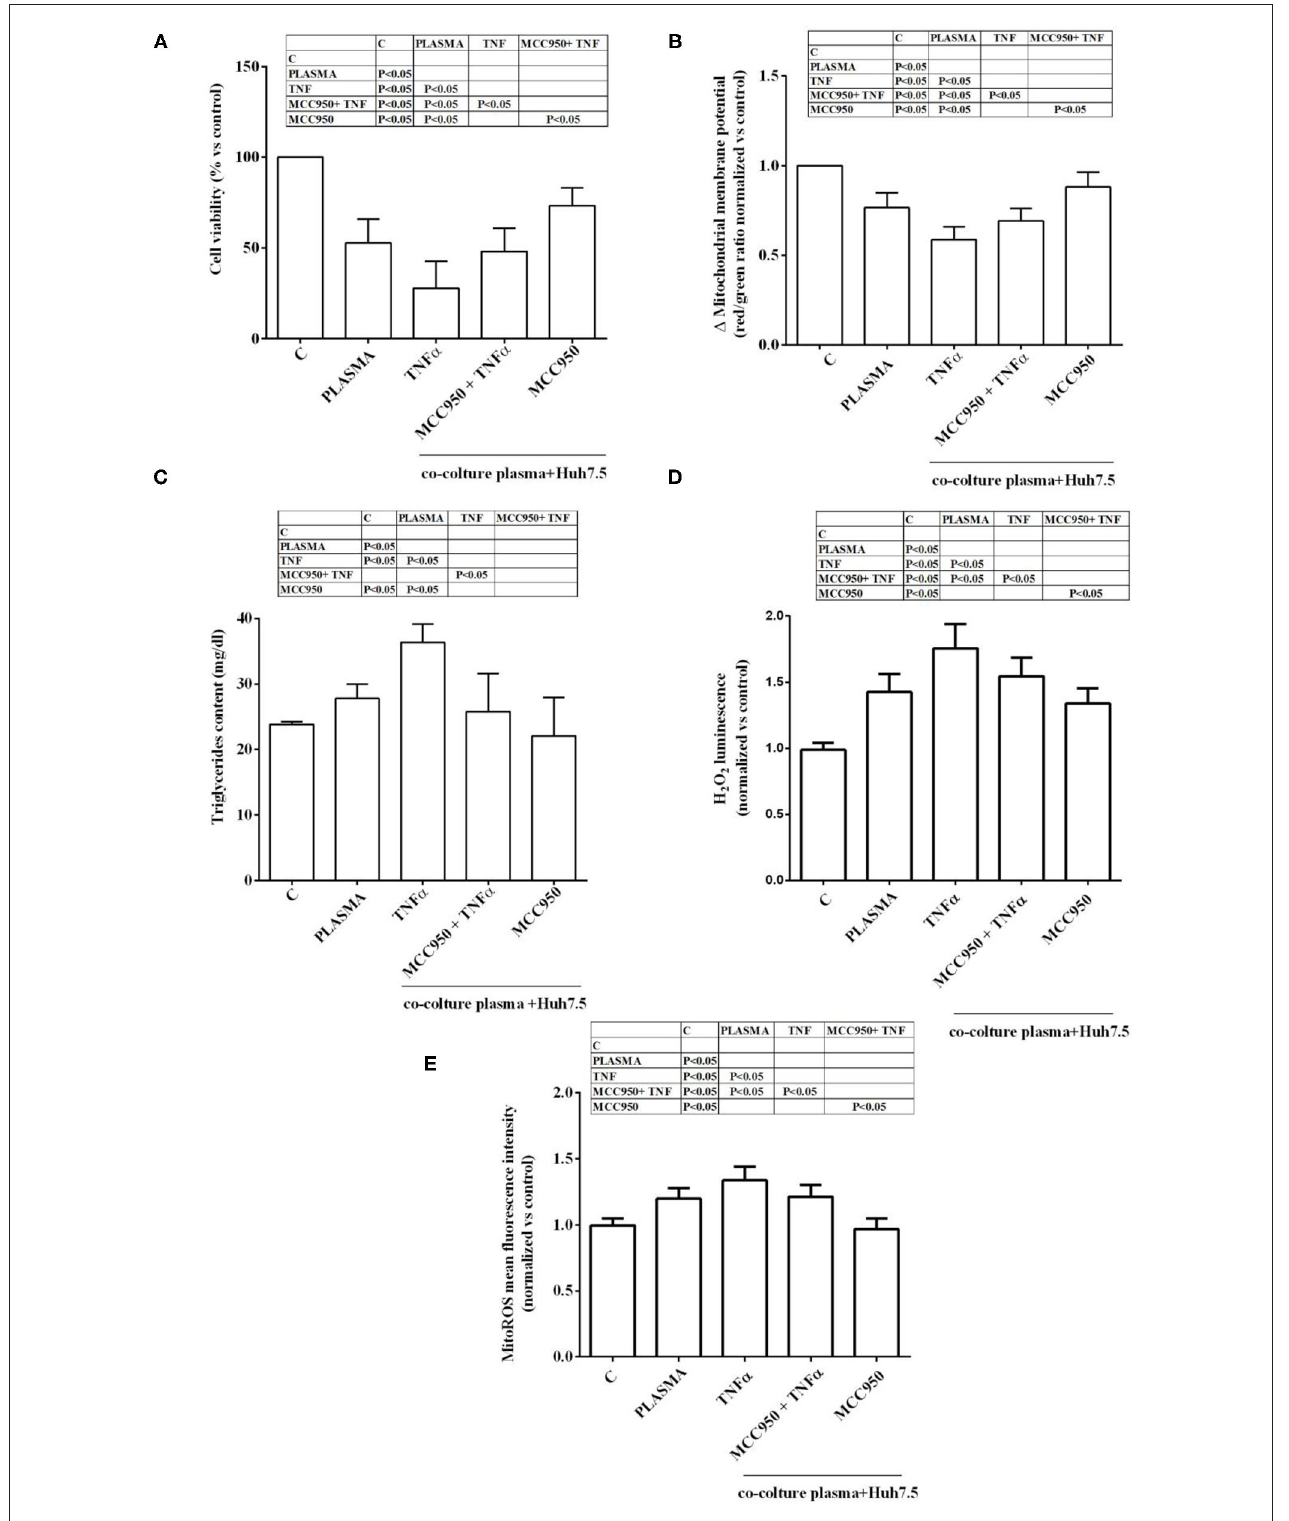
FIGURE 1 | Effects of NAFLD plasma on Huh7.5 cell viability (A) , mitochondrial membrane potential (B) , triglycerides content (C) , H 2 O 2 release (D) and mitochondrial ROS (mitoROS, E ). C = non-treated cells. MCC950 (NLRP3 inflammasome inhibitor, 1 nM for 30 min); TNF α (200 pM for 3 h). Reported data are means ± SD of five independent experiments for each experimental